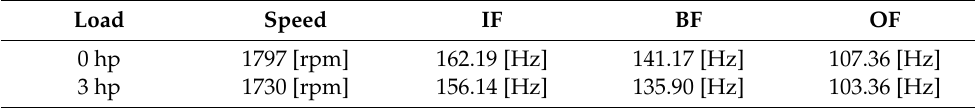
Table 4. Test load and bearing fault characteristic frequency.